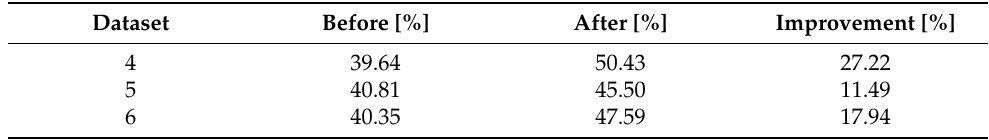
Table 6. Improved recognition accuracies obtained from f b